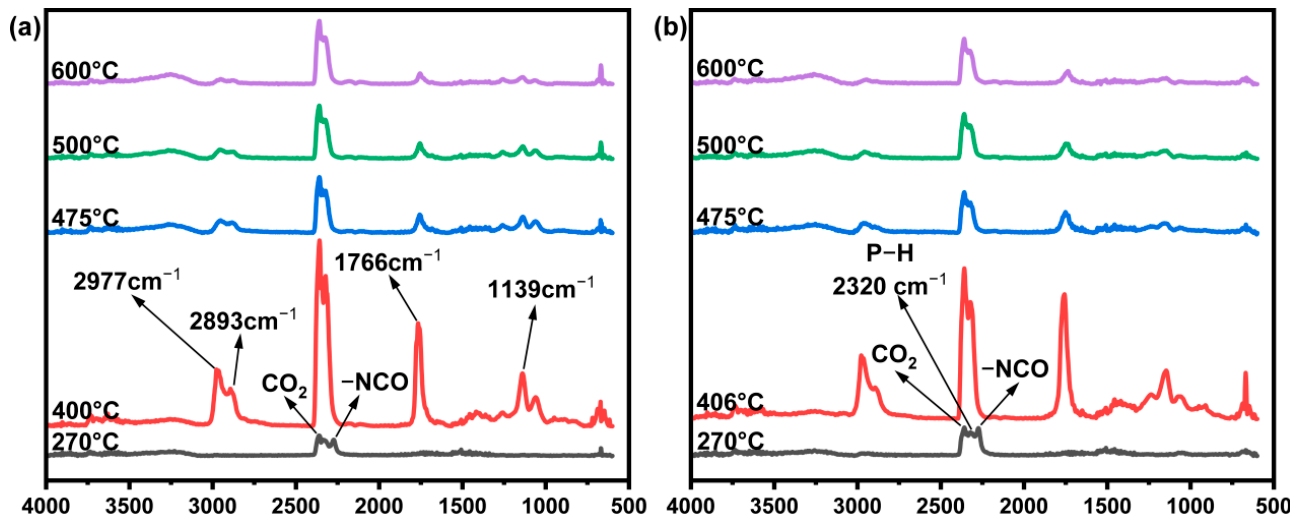
Figure 9. TG-IR spectra of the gaseous phase in the thermal degradation for R-FPUF ( a ) and P-FPUF ( b ) at different temperature.